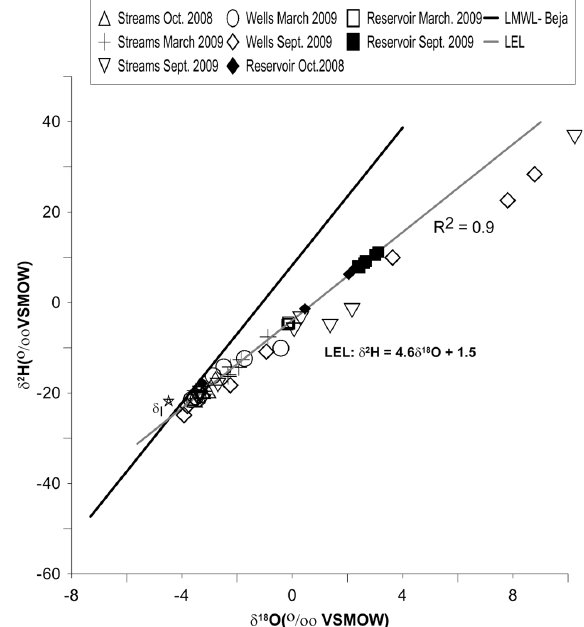
Fig. 3. Distribution of stream water isotope chemistry along the global (GMWL) and local meteoric water lines (LMWL).